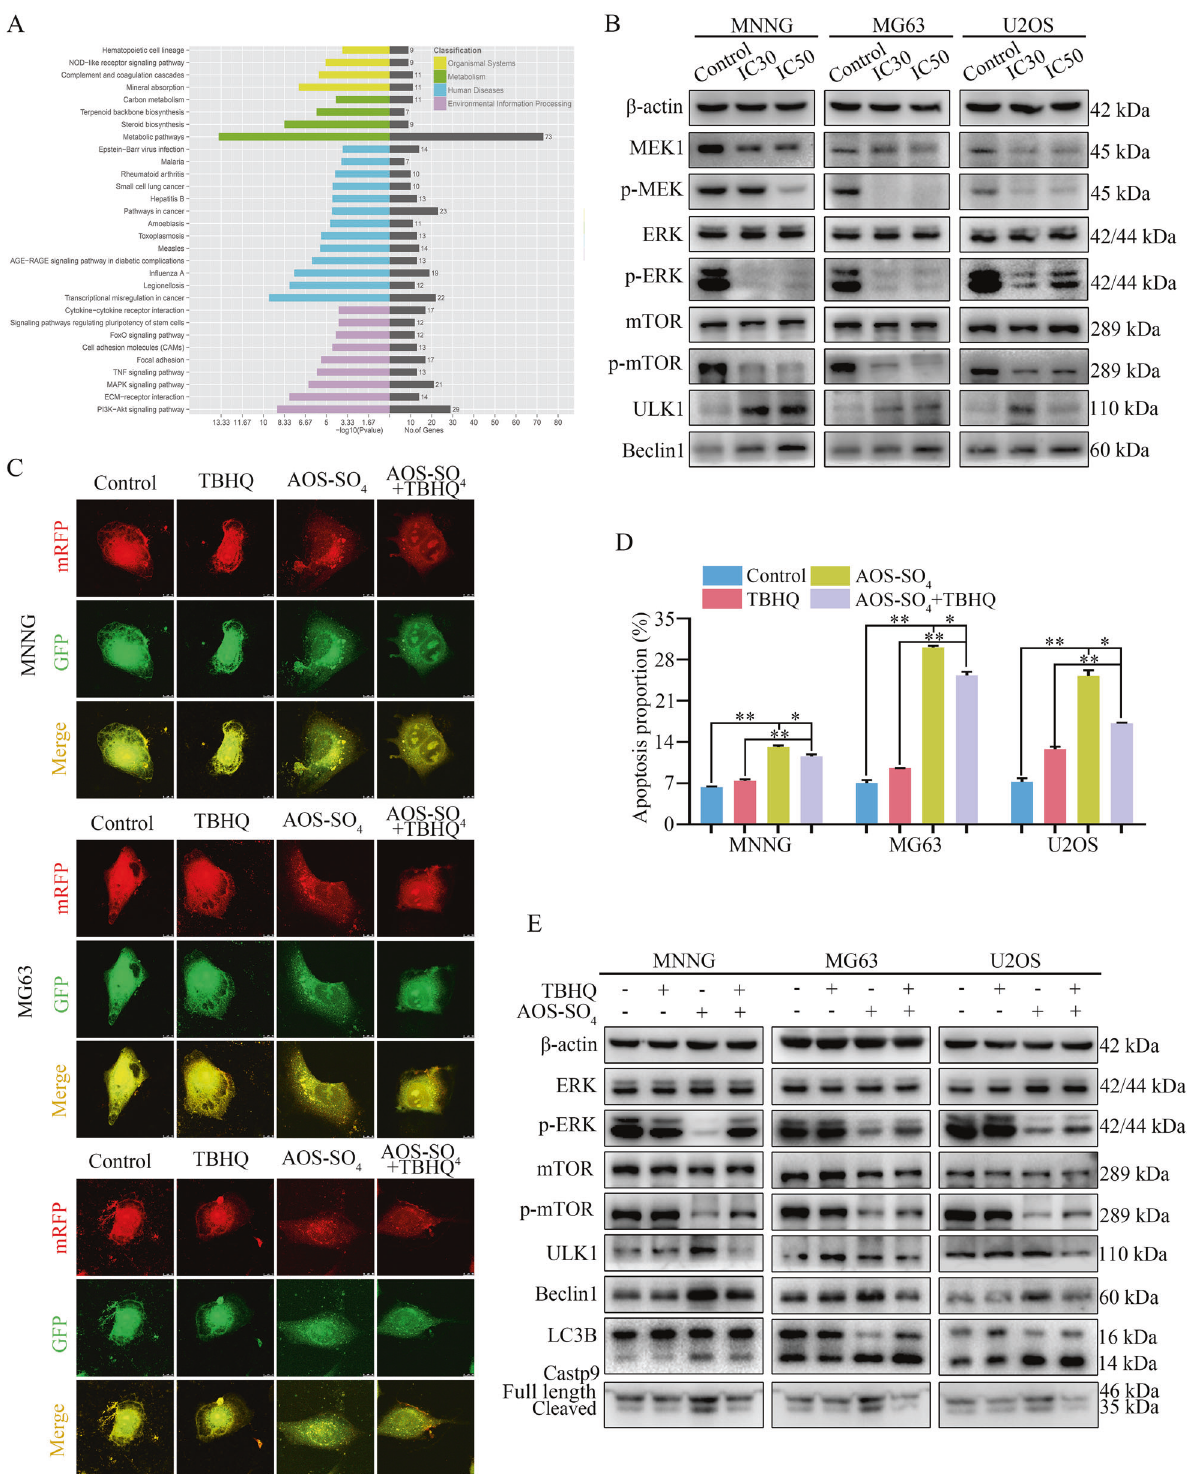
Fig. 5 AOS-SO 4 promotes autophagy and induces apoptosis through the MEK1/ERK/mTOR signaling pathway. A KEGG pathway analysis of the differentially expressed genes in AOS-SO 4 -treated MNNG cells and control cells. B Representative blots showing the protein expression of MEK1, p-MEK1 ERK, p-ERK, mTOR, p-mTOR, and LC3B after treatment with AOS-SO 4 . C Osteosarcoma cells were treated with AOS-SO 4 for 48 h with or without TBHQ, and LC3 puncta were analyzed by the mRFP-GFP-LC3 construct. D Apoptosis was assessed by fl ow cytometry analysis after treatment with AOS-SO 4 for 48 h with or without TBHQ. E Representative blots of p-ERK, p-mTOR, ULK1, Beclin1, LC3B, and Casp9 in MNNG, MG63, and U2OS cells after treated with AOS-SO4 for 48 h with or without TBHQ. Data are shown as the means ± SD from at least three independent experiments. Statistical analysis was performed using Student ’ s t -test. Error bars represent the SEM. * P < 0.05; ** P <